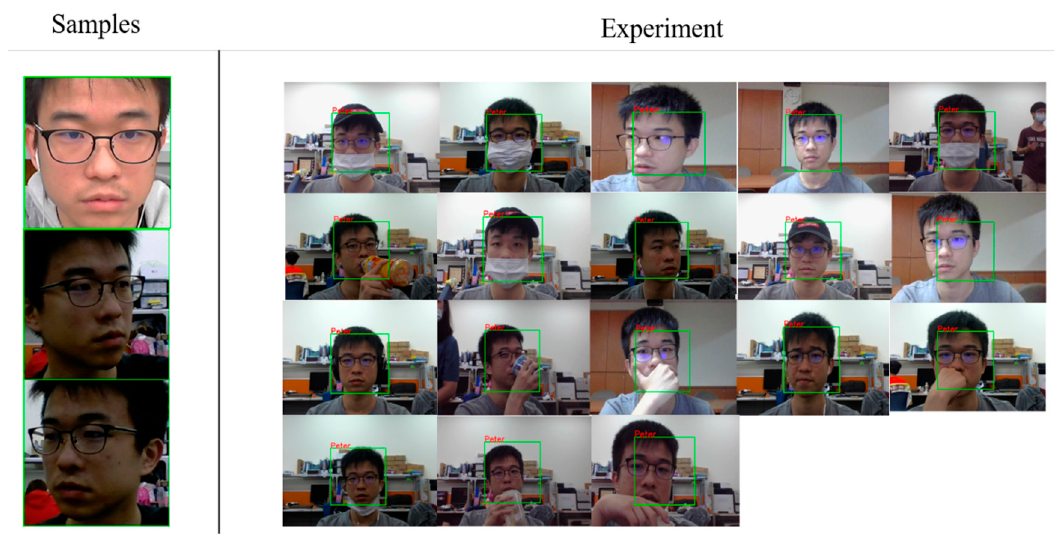
Figure 11. Real-time camera recognition of a known face under various conditions (with three samples).